Question: Provide a one-line summary of what is displayed.
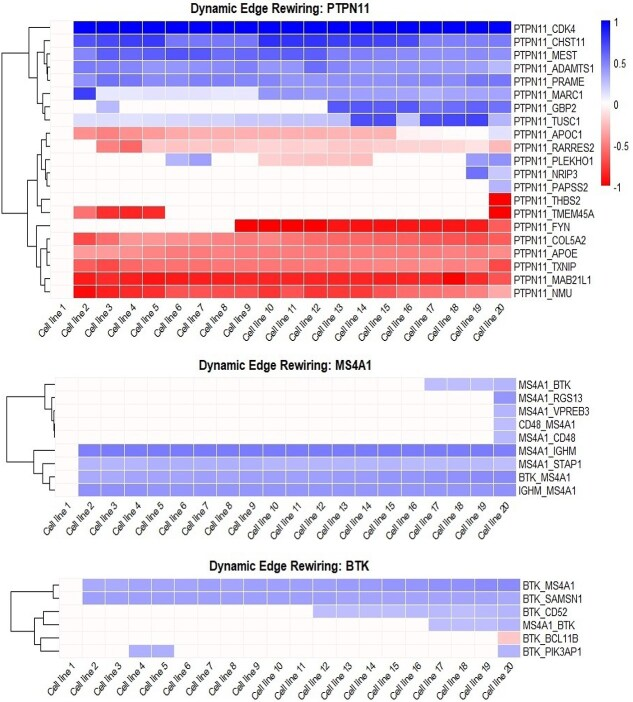
Answer: Dynamic edge rewiring and differential network topology linked to resistance evolution. A transition from “Node Scoring” to “Network Mechanism” illustrates specific rewiring events of top-ranked genes associated with increasing drug resistance. The heatmaps display the evolution of edge weights for interaction partners of PTPN11 (top), MS4A1 (middle), and BTK (bottom) across cell-line states ordered from the most sensitive (Cell line 1) to the most resistant (Cell line 20). Because CellGNEA is based on directed cell-line-specific gene networks, edge labels are represented in the form “Regulator \documentclass[12pt]{minimal} \usepackage{amsmath} \usepackage{wasysym} \usepackage{amsfonts} \usepackage{amssymb} \usepackage{amsbsy} \usepackage{upgreek} \usepackage{mathrsfs} \setlength{\oddsidemargin}{-69pt} \begin{document} ${\_}$\end{document} Target,” where the left and right gene names denote the regulator and target genes, respectively. Consequently, labels such as “MS4A1 \documentclass[12pt]{minimal} \usepackage{amsmath} \usepackage{wasysym} \usepackage{amsfonts} \usepackage{amssymb} \usepackage{amsbsy} \usepackage{upgreek} \usepackage{mathrsfs} \setlength{\oddsidemargin}{-69pt} \begin{document} ${\_}$\end{document} BTK” and “BTK \documentclass[12pt]{minimal} \usepackage{amsmath} \usepackage{wasysym} \usepackage{amsfonts} \usepackage{amssymb} \usepackage{amsbsy} \usepackage{upgreek} \usepackage{mathrsfs} \setlength{\oddsidemargin}{-69pt} \begin{document} ${\_}$\end{document} MS4A1” represent distinct directed regulatory relationships rather than the same undirected interaction. Interaction partners were hierarchically clustered within each panel according to similarity in dynamic edge rewiring patterns across cell-line states. Therefore, edge ordering and displayed interaction-partner labels reflect clustering-derived network topology and are intended to highlight groups of directed interactions exhibiting similar resistance-associated rewiring behaviors.